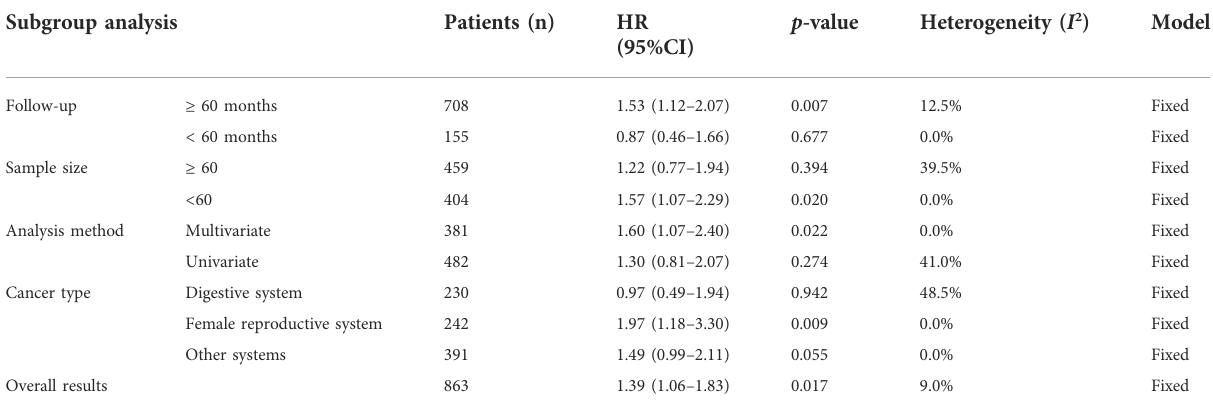
TABLE 2 Result of SNHG14 expression with overall